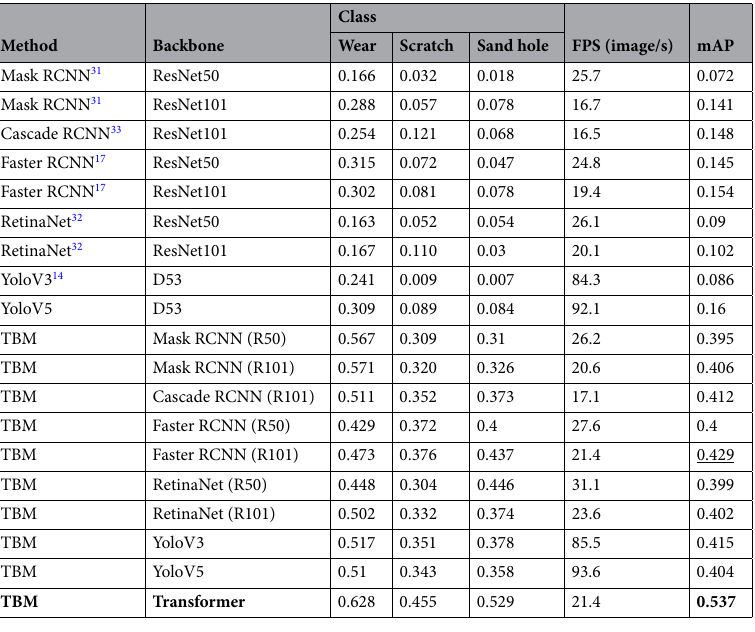
Table 6. Performance comparison and detection efficiency between our proposed method and the state- of-the-art algorithms in object detection. The best and second best results are in bold and underlined, respectively. R50 and R101 represent ResNet50 and ResNet101,